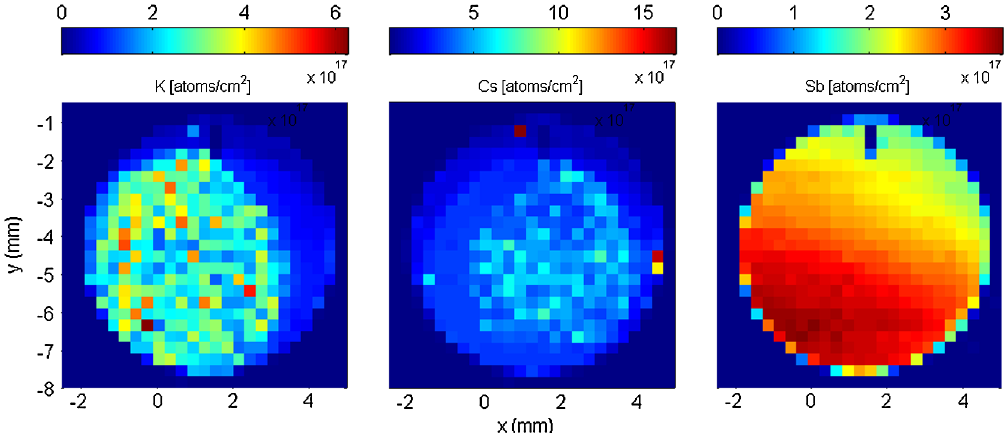
FIG. 2. XRF maps for K (left), Cs (middle), and Sb (right). A notch had been scribed in the sample for orientation purposes. The orientation of these scans corresponds to that of the above QE scans. The stoichiometry, normalized to the Sb areal density, averaged Cs Sb , where the values for the potassium areal density should be treated as a lower bound over the active area was found to be K 0 : 8 1 : 29 on the actual value (see